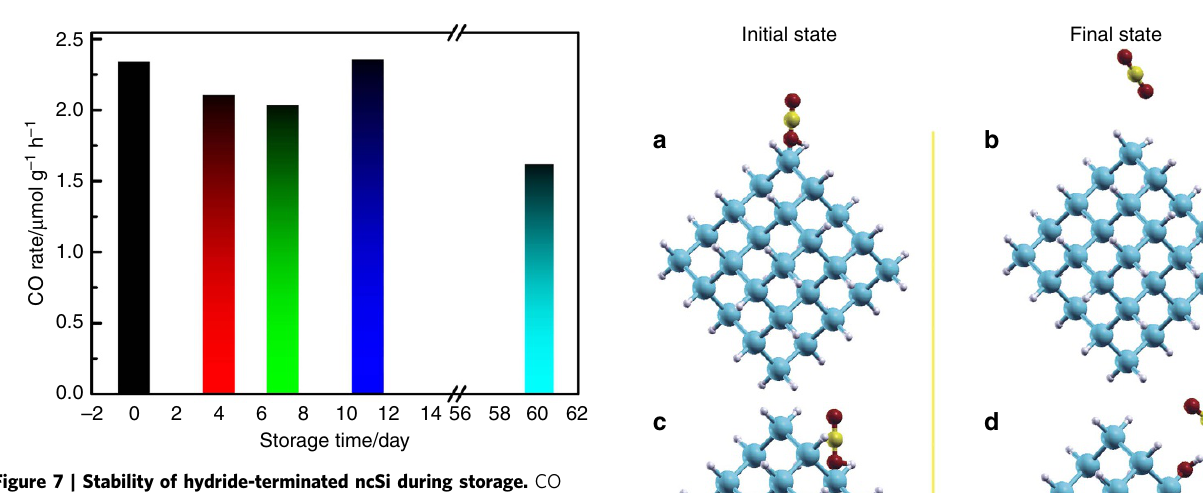
Fig. 8f. The calculated binding energy of CO 2 on the Si site is 0.63 eV. The C–O bond lengths for CO 2 molecule increased from 1.16 to 1.22 Å and 1.53 Å, and the bond angle reduced from 180 (cid:2) to 121.2 (cid:2) . However the dangling bond Si site is not able to dissociate CO 2 . Interestingly, the SiH site managed to dissociate CO 2 into CO and Si–OH endothermically (adsorption energy E 0.11 eV) making surface SiH the most favourable site for CO 2 reduction reaction in ncSi:H system (Fig. 8d). The C–O and O–H bond lengths of the products are 1.17 and 1.01 Å, respectively, the Bader charges on O and C of CO are (cid:2) 1.79e and þ 1.74e, respectively, and Bader charge on O and H of OH are (cid:2) 2.07e and 0.00e, respectively. The strong bonds and charge distribution show that products formed by CO 2 dissociation on the SiH site are very stable.